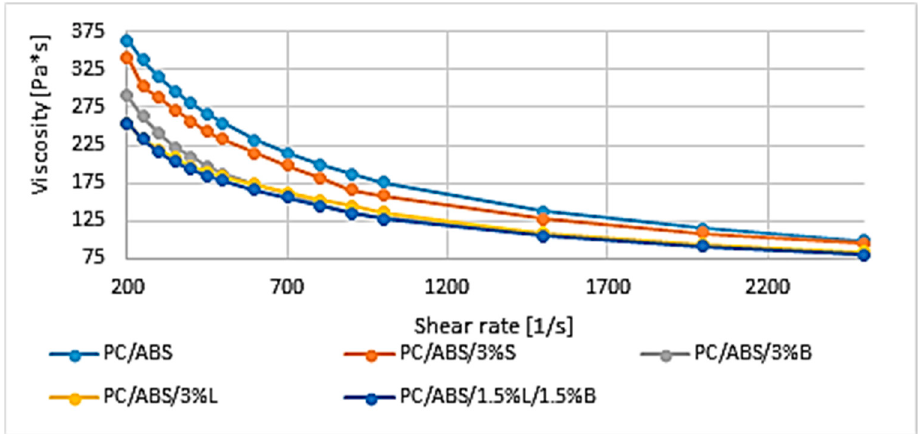
Figure 4. Viscosity curves of PC/ABS and composites based on PC/ABS.